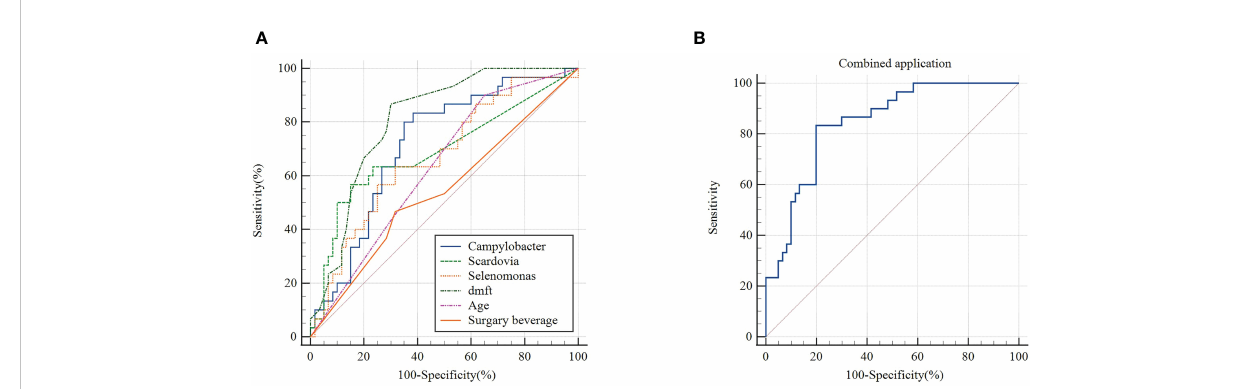
FIGURE 6 (A) ROC curve of single index (Campylobacter, Scardovia, Selenomonas, dmft, age, frequency of sugary beverage intake) in group H (B) ROC curve of combined application of each single index in group